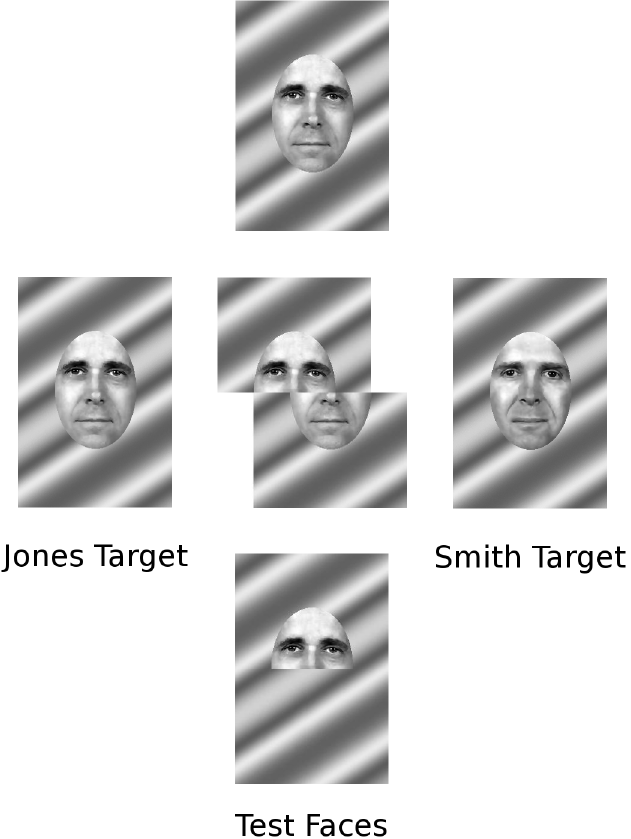
Fig 1. Target faces and sample together whole, split whole, and half test